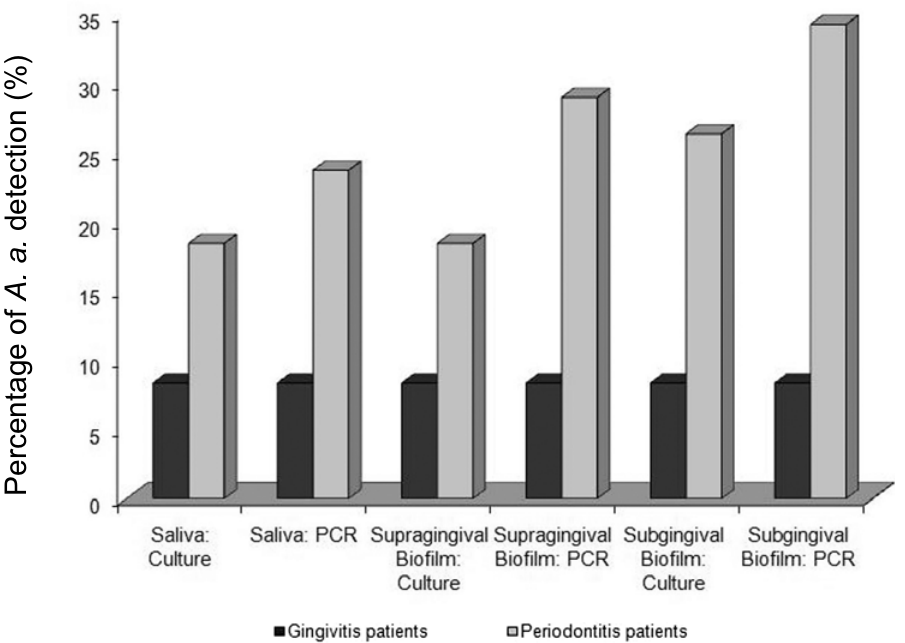
FIGURE 1- Detection of Aggregatibacter actinomycetemcomitans in saliva, supragingival biofilm, and subgingival biofilm from Brazilian Indians by culture and